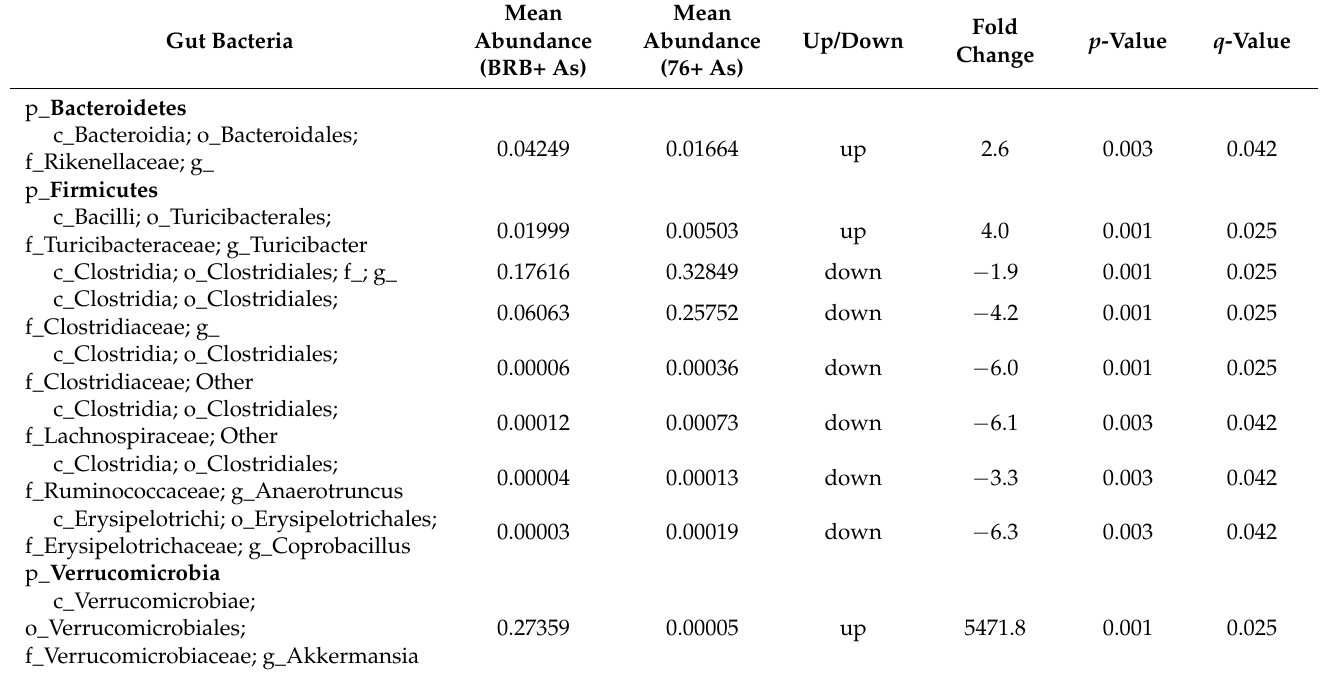
Table 1. Effects of dietary administration of BRBs on gut microbial composition of mice upon As